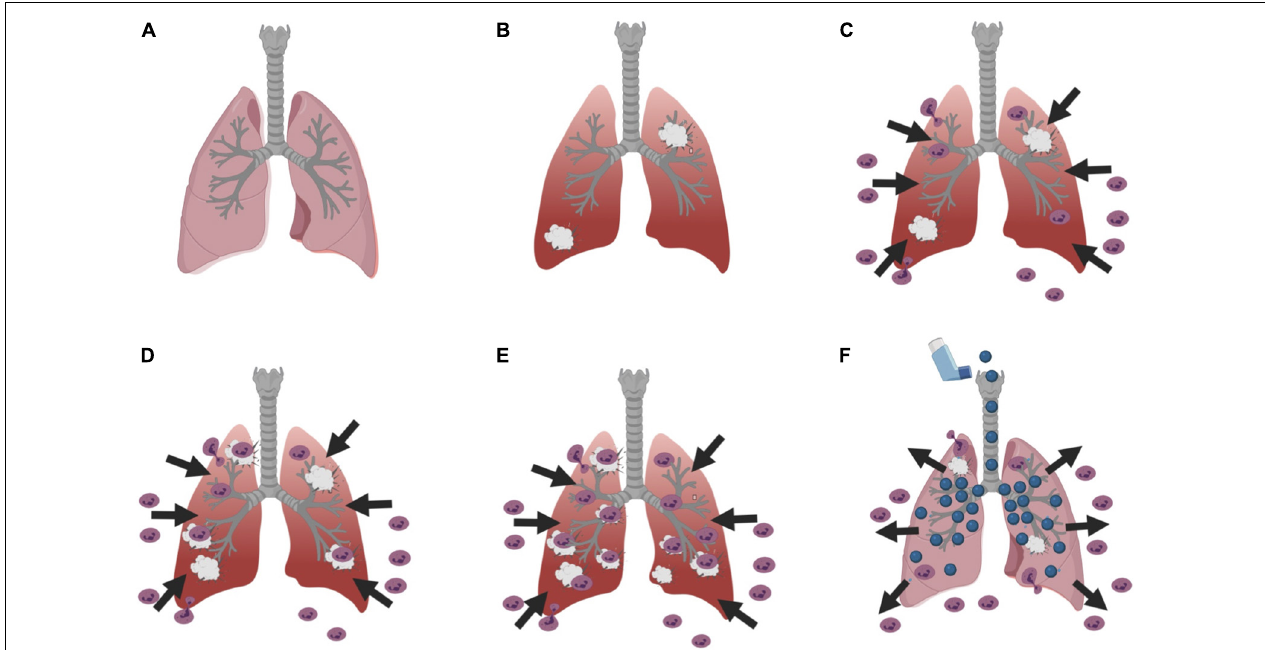
FIGURE 1 | Diagram of the basic process of ARDS and a potential therapeutic mechanism. (A) A cartoon of a normal lung, and (B) a lung with damage. (C) Neutrophils leave the blood and enter the lung tissue and airspaces in response to the damage. (D) In ARDS, this can result in further lung damage, which (E) results in even more neutrophils attracted to the lungs causing more damage in a vicious cycle. (F) An intriguing possibility is that inhalation of a nebulized neutrophil chemorepellent could drive neutrophils out of the lungs and/or prevent neutrophils from entering the lungs, and thus break the vicious cycle and reduce neutrophil-induced lung damage. Figures were created using